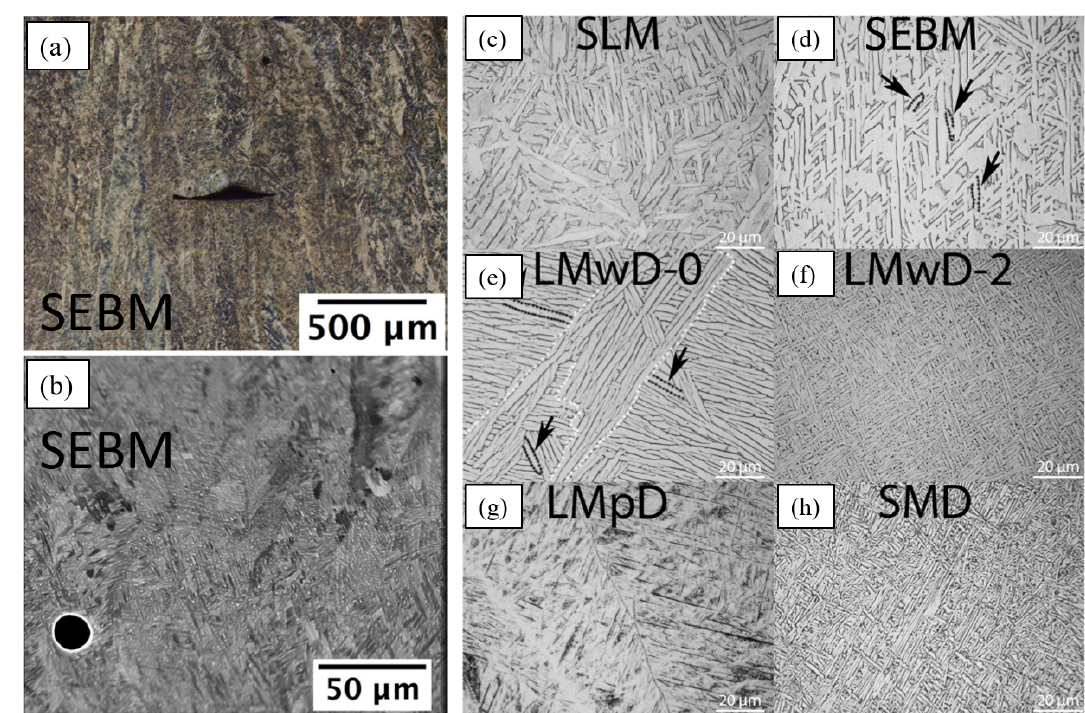
Figure 4. Microstructural features of SEBM additive Ti-6Al-4V: ( a ) irregular pore attributed to lack of fusion; and ( b ) spherical pore attributed to gas trapped within the powder feedstock. Microstructures of Ti-6Al-4V showing a basketweave type structure produced by the following additive processes: ( c ) SLM; ( d ) SEBM; ( f ) LMwD (with a 2-min dwell time between deposited layers); and ( h ) SMD. Ti-6Al-4V produced by: ( e ) LMwD (with no dwell time between sequentially deposited layers) showing a Widmanstätten type structure; and ( g ) LMpD showing a martensitic structure. In ( c – h ). the residual β phase appears dark between the α platelets. Images in ( a , b ) and ( c – h ) reproduced with permission from Cunningham et al. [31] and Neikter et al. [29],